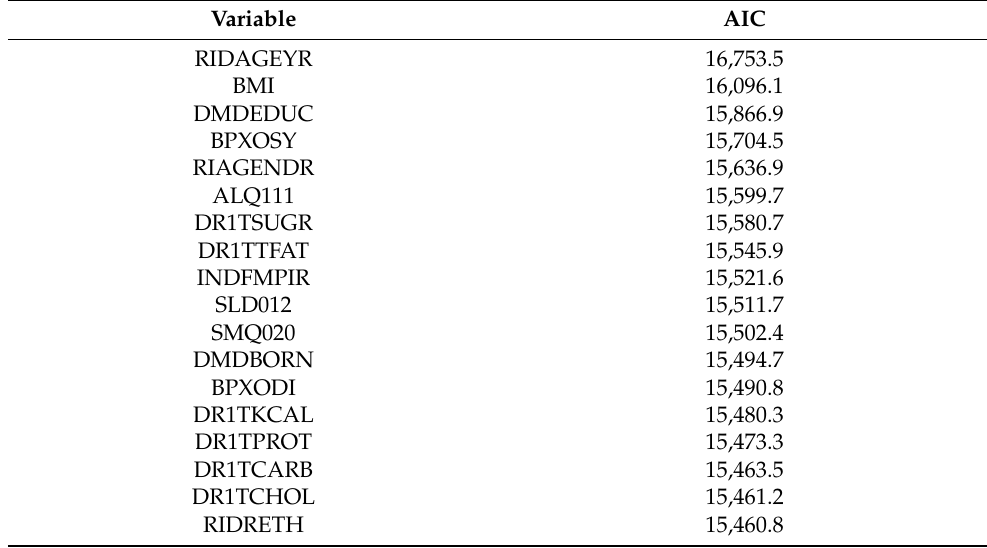
Table 2. Process table for feature selection with reference to the Akaike Information Criterion.